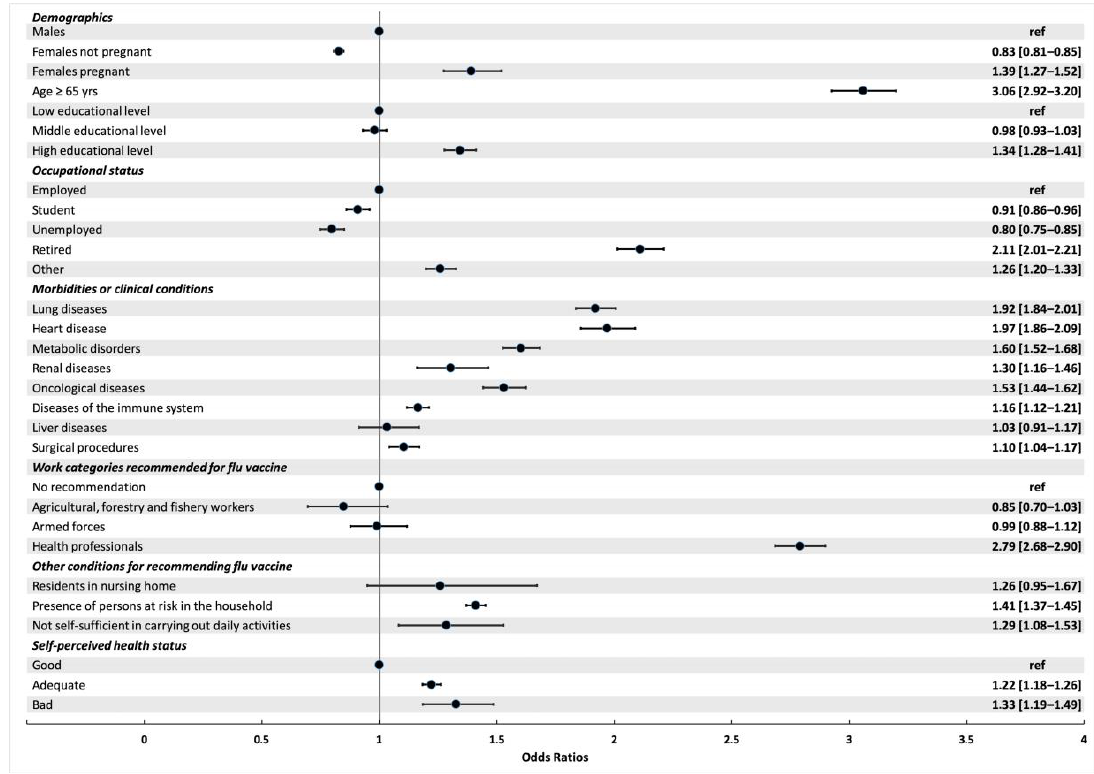
Figure 2. Multivariable model of factors associated to flu vaccination in the 2019/2020 season in respondents aged ≥ 18 years.